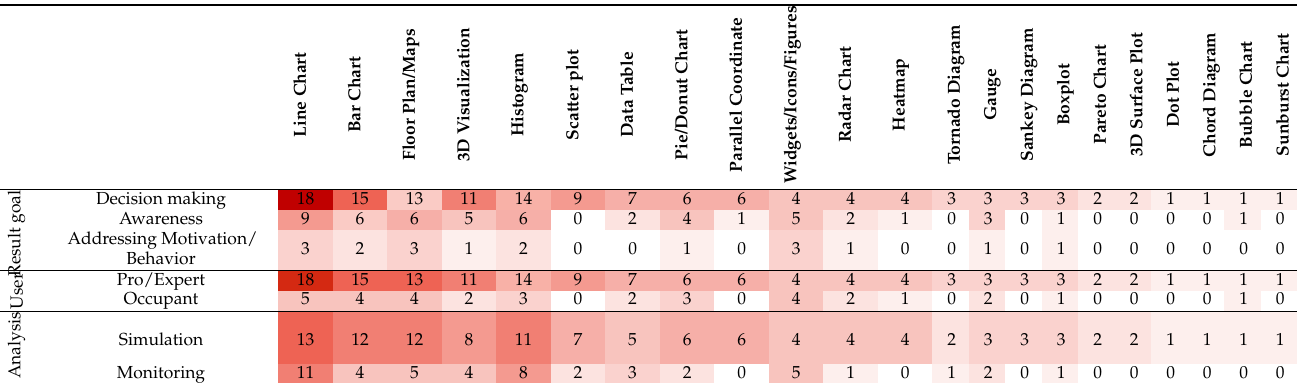
Table 2. Number of occurrences per visualization type, per goal of the energy report, per user, and type of building energy analysis.